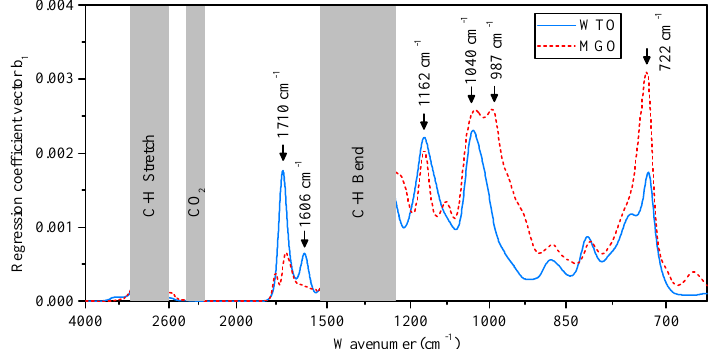
Figure 2. Regression coefficient vector b 1 constructed by the partial least squares (PLS) algorithm for the WTO and the MGO oil samples. The local maxima of b 1 are highlighted, as they denote spectral regions with high influence on the acid number